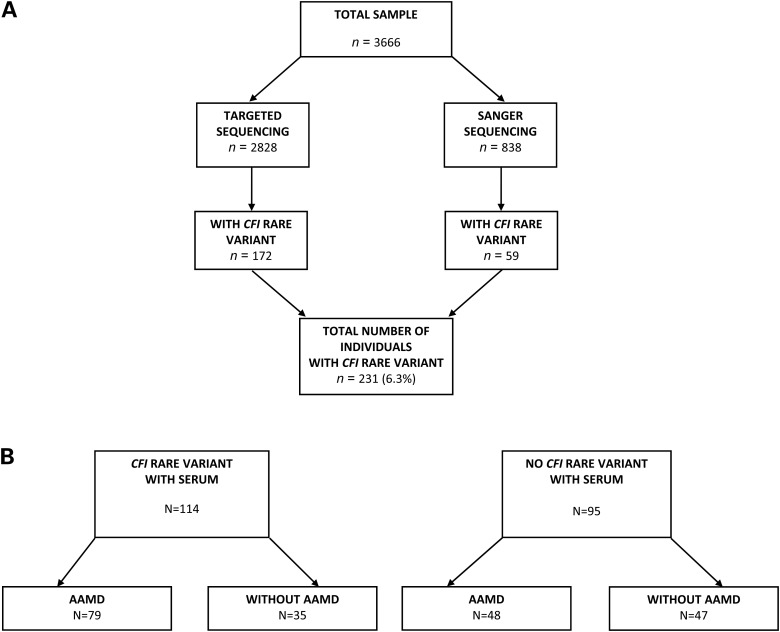
(A). Flow chart for sequencing and discovery of CFI rare variants. AAMD: advanced age-related macular degeneration. Targeted sequencing was performed on 2828 individuals, including 2421 previously sequenced unrelated AAMD cases and controls without any signs of AMD (145 individuals with CFI genetic variants) (9), and 407 additional unrelated cases and controls sequenced in the same manner (27 new individuals with CFI genetic variants identified). Sanger sequencing was performed on 838 individuals, including 396 cases with AAMD and 442 controls without any signs of AMD (59 new individuals with CFI genetic variants identified). A total of 231 subjects with CFI rare variants were identified. (B) Flow chart for selection of samples for serum analysis. In order to explore the effects of disease and CFI rare variants on serum FI levels, we first identified individuals with a variant and with AAMD for whom serum samples were available (n = 79). We identified three comparison groups from the sequenced individuals with similar mean ages at the time of blood draw compared with the advanced AMD cases carrying a variant: (i) subjects with AAMD but no variant (n = 48), (ii) a group without AAMD and without a variant (n = 47) and (iii) subjects without AAMD but with a variant (n = 35). The total sample comprised 209 subjects, with 114 carrying rare CFI variants.